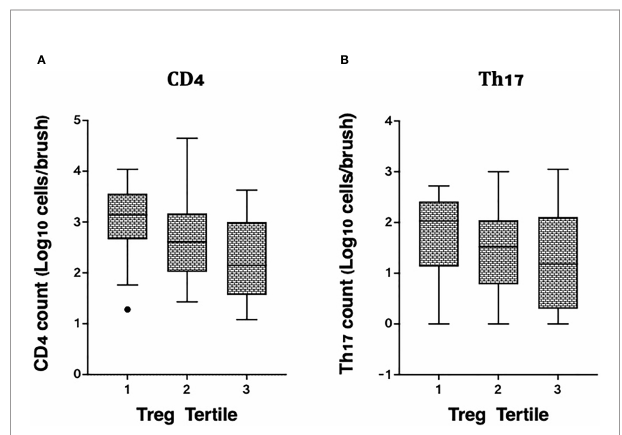
FIGURE 4 | Correlation of cervicovaginal Treg frequencies with absolute counts of HIV target cells per cytobrush, including: (A) CD4 and (B) Th17 cell counts per brush in the female genital tract. For statistical analysis, see Table 3